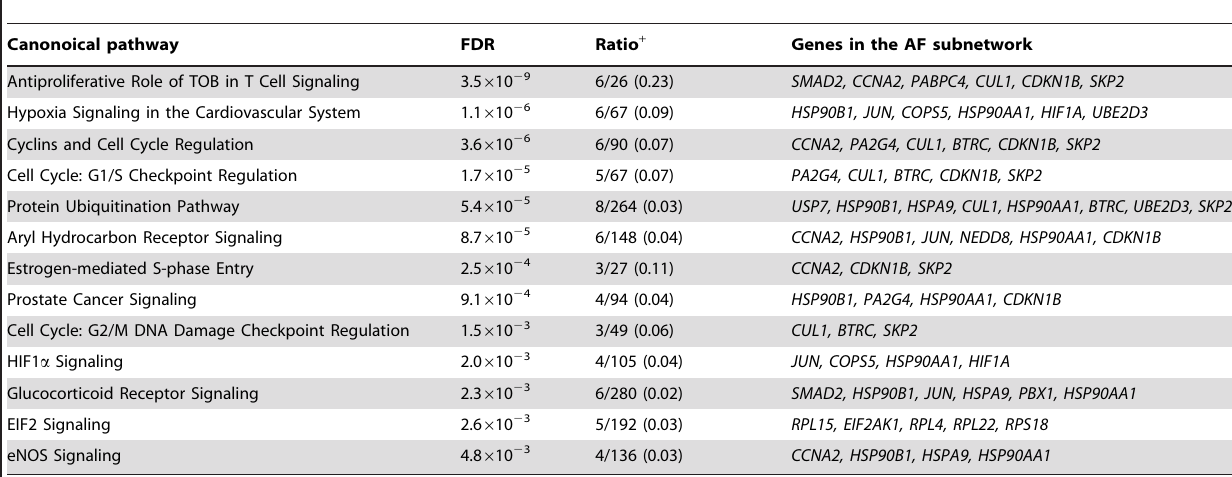
Table 3. Most significant canonical pathways enriched with genes in the AF subnetwork (FDR , 0.005).